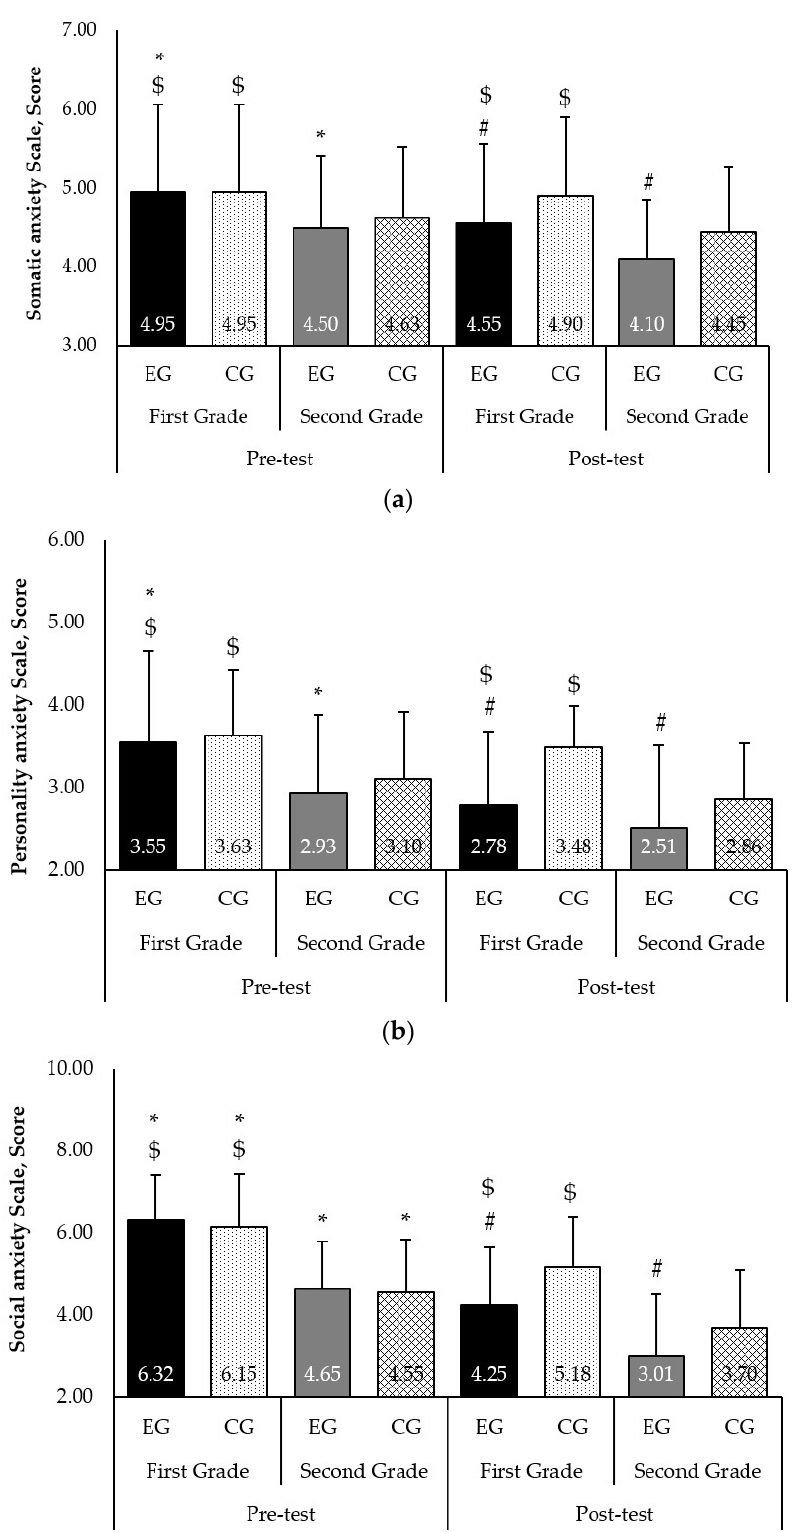
Figure 1. Pre- and post-test levels of somatic anxiety ( a ), personality anxiety ( b ), and social anxiety ( c ) in primary school children. # , p < 0.05 between experimental and control groups; $ , p < 0.05 between First and Second Grades; *, p < 0.05 between pre- and post-test.